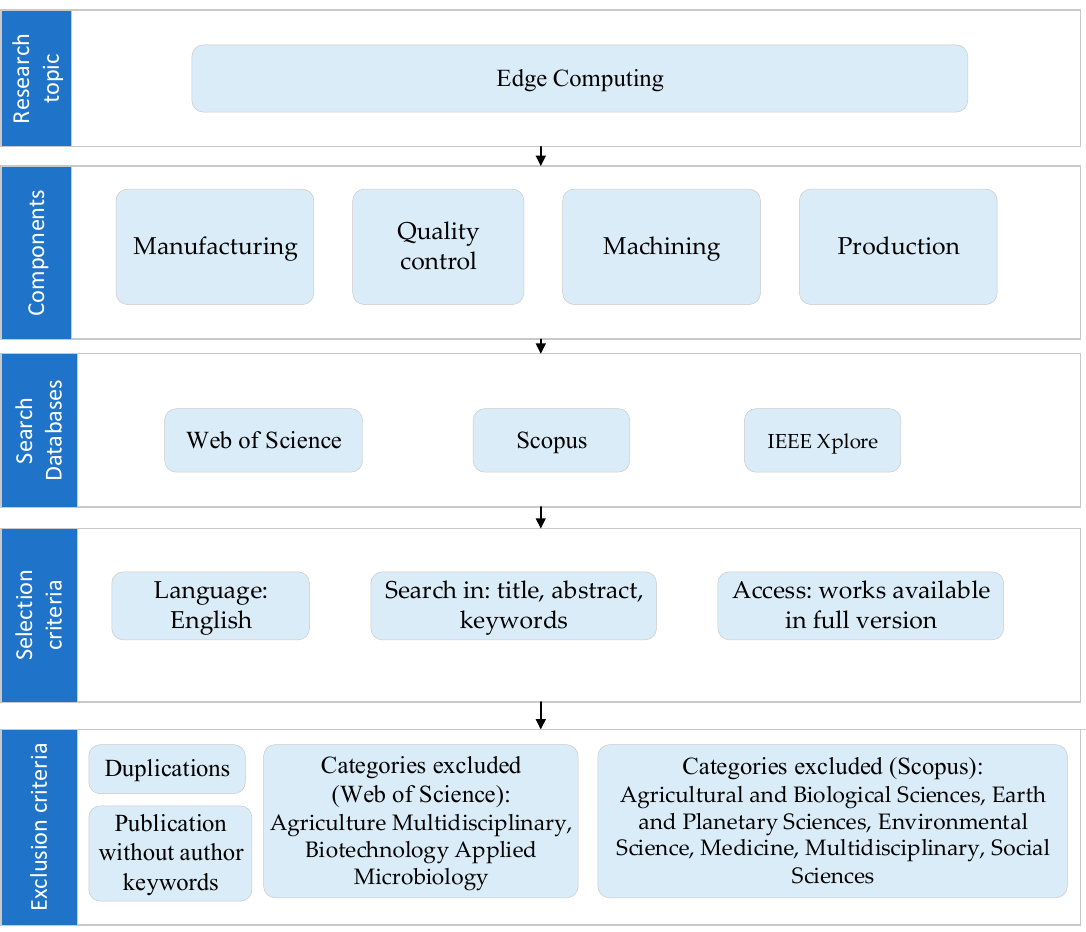
Figure 1. Data extraction plan.